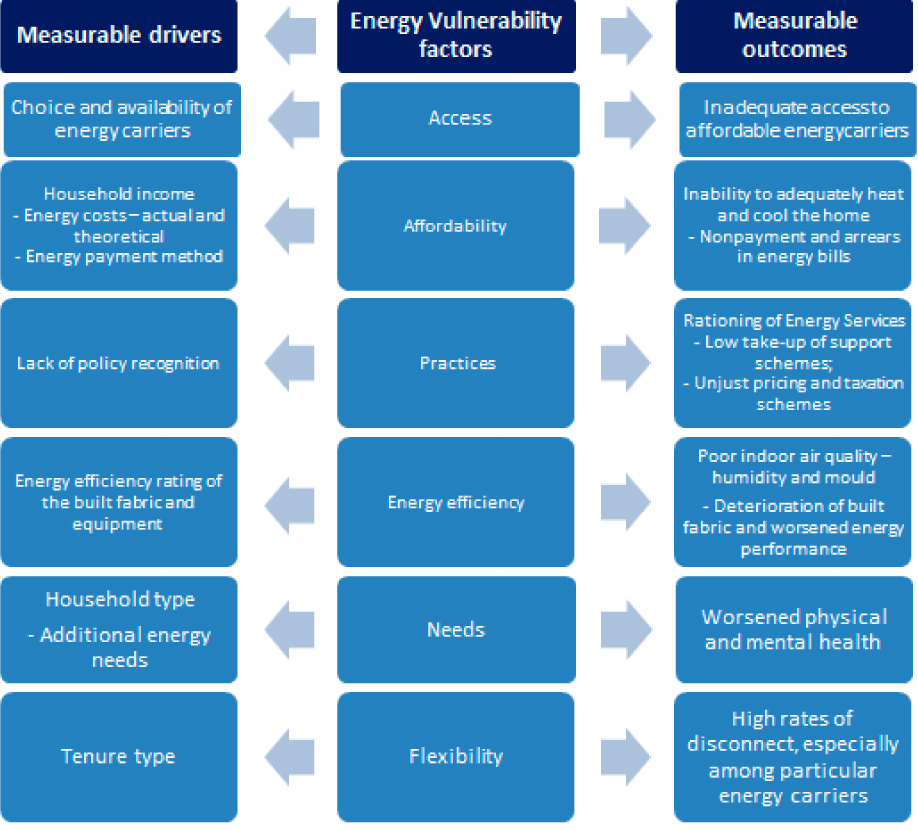
Figure 3. Arrangement of measurable drivers and outcomes by energy vulnerability factors. Source: